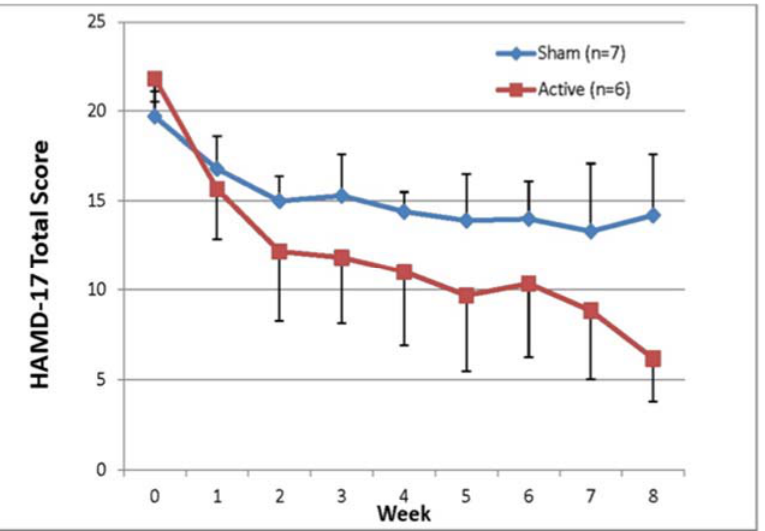
Figure 2. Antidepressant effect of tPBM versus sham [35] , 2x/week over 8 weeks. (Figure re ‐ used with permission from Photobiomodulation, Photomedicine, and Laser Surgery). with permission from Photobiomodulation, Photomedicine, and Laser